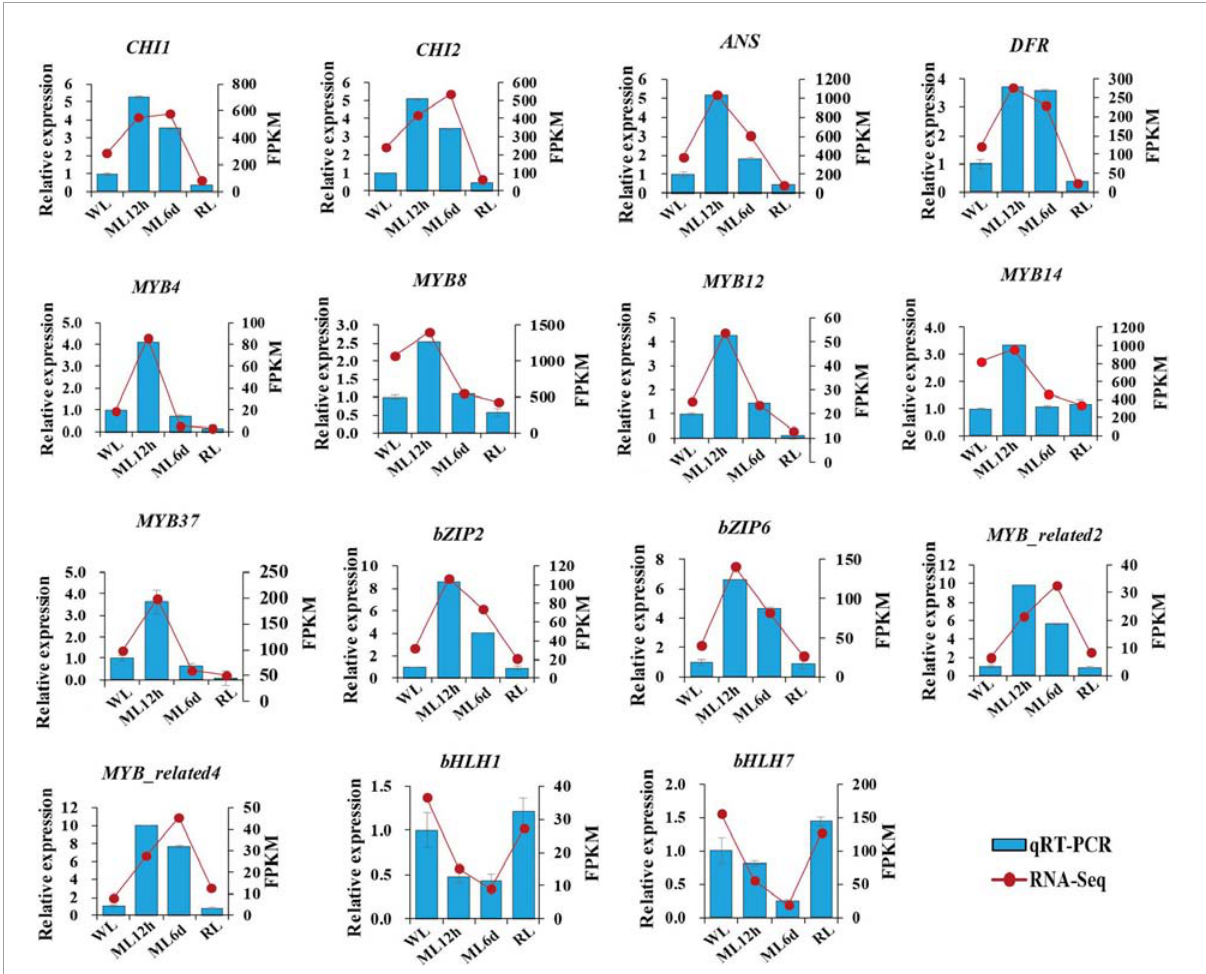
FIGURE8 Relative expression levels of candidate genes. The histogram indicates gene expression data form qRT-PCR. The line chart indicates FPKM from transcriptomic sequence. Data are presented as means ± standard deviation ( n =